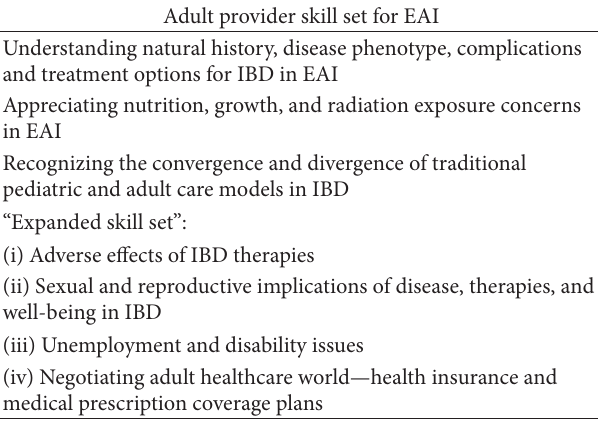
Table 2: Provider skill set (EAI: emerging adult with